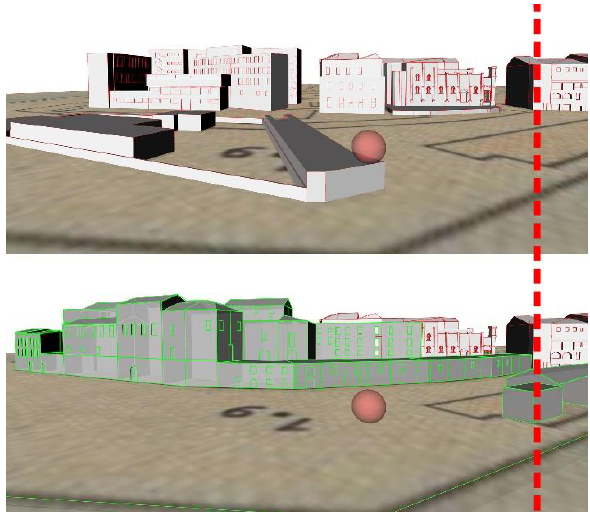
Figure 13: Position of the point of view of a 7-fish-eye photos group in the real site (above) and in the reconstructed